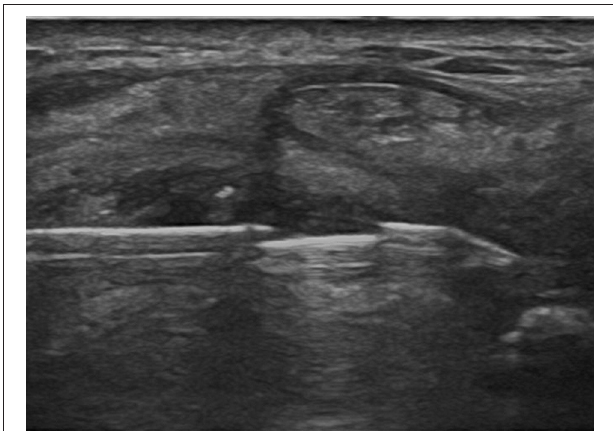
FIGURE 7 | Biopsy needle inside the joint.